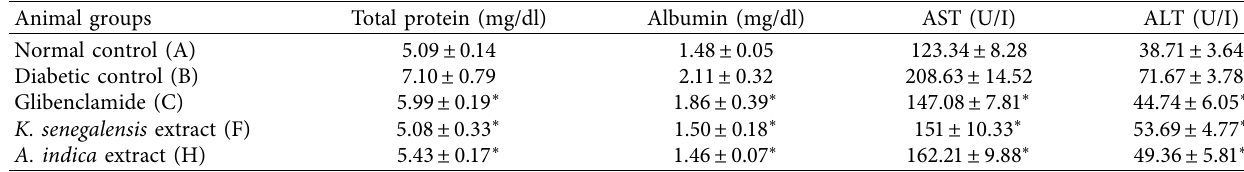
Table 3: Efect of oral administration of K. senegalensis stem bark and A. indica leaves hydroethanolic extracts on protein and liver function markers of diabetic rats.